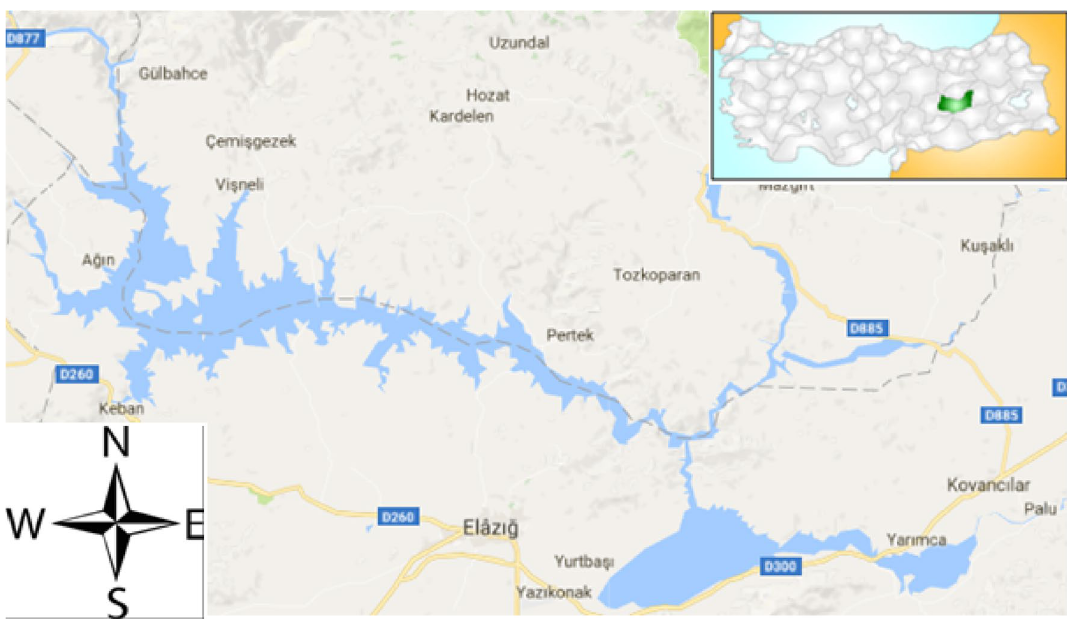
Figure 2. The map of Keban Dam Lake [Google Maps: https:// www. google. com/ maps/@ 38. 80250 12,38. 91705 08,9z (Accessed 10 February 2021)] 21